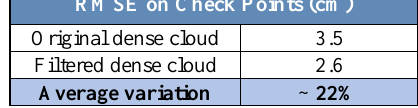
Table 6: Average cloud-to-cloud distance